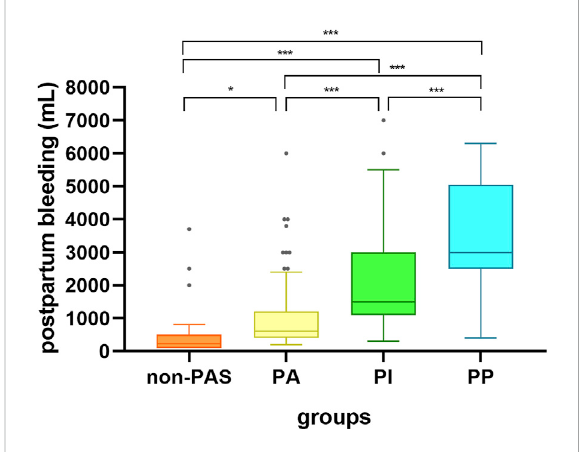
FIGURE 4 Box diagram representation of bleeding volume in the four groups of patients. non-PAS: no placenta accreta spectrum disorders; PA, placental adhesion; PI, placental implantation; PP, placenta percreta; * p < 0.05; *** p <